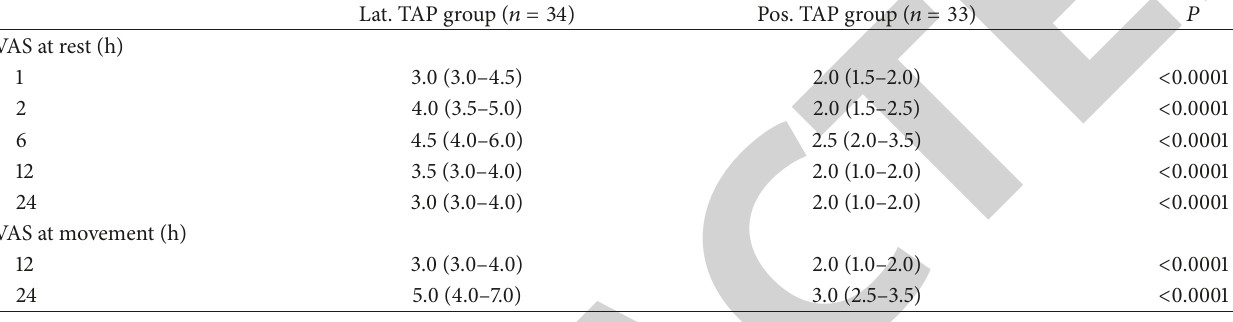
Table 3: Postoperative VAS scores during both rest and movement: data expressed as median (twenty-fifth to seventy-fifth percentiles). Lat. TAP group ( 𝑛 = 34 )